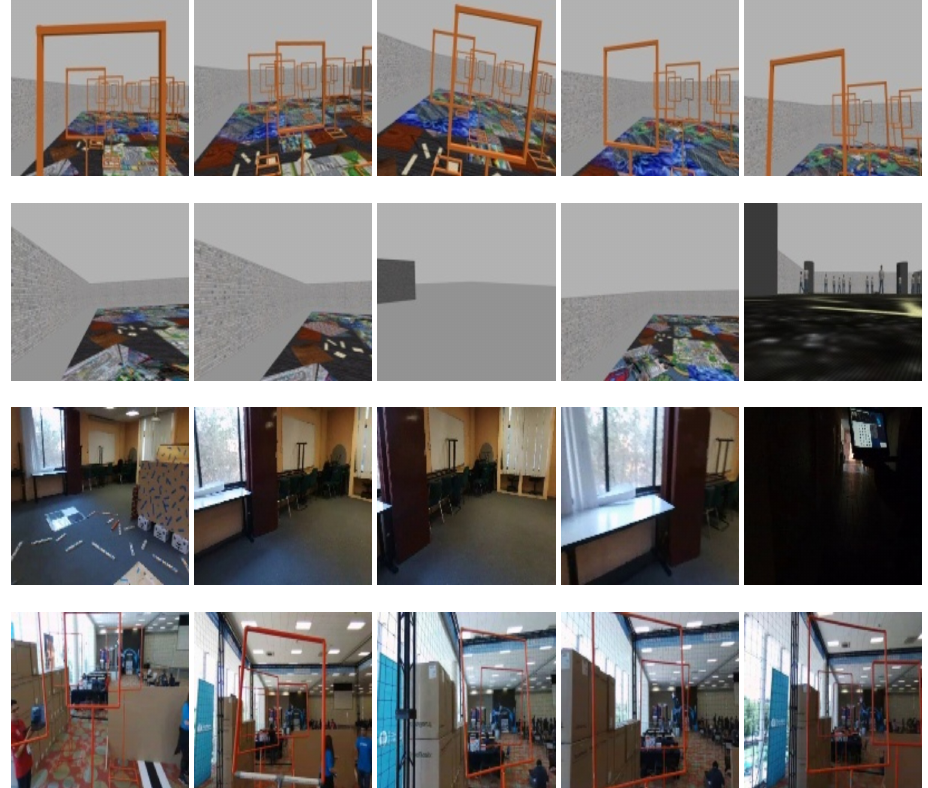
Figure 7. Example of images from the database collected from real scenarios and simulated scenarios. These images include examples of background images and images with gates in both simulated and real